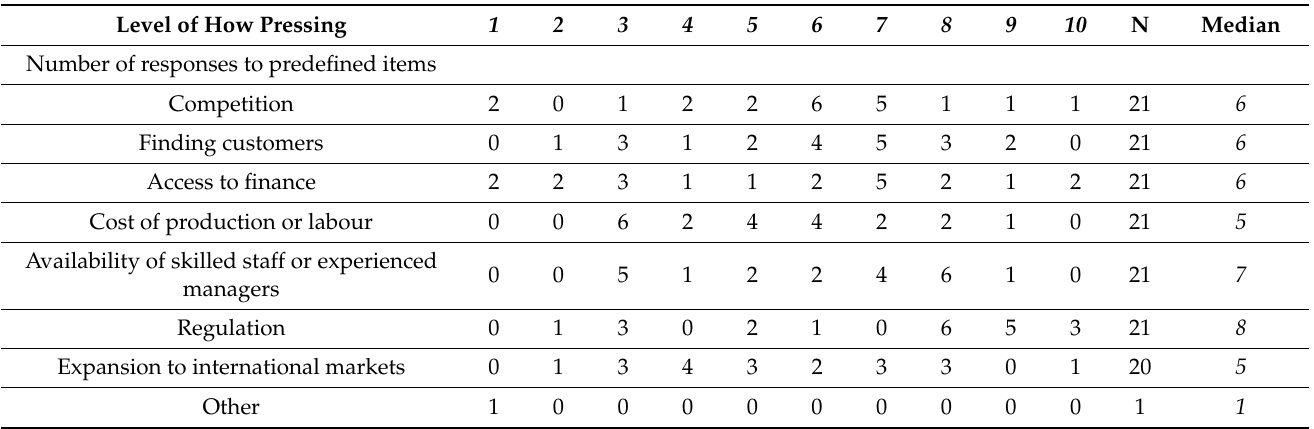
Table 2. Responses to the question how pressing specific problems are; 1 = not pressing, 10 = extremely pressing. Level of How Pressing 1